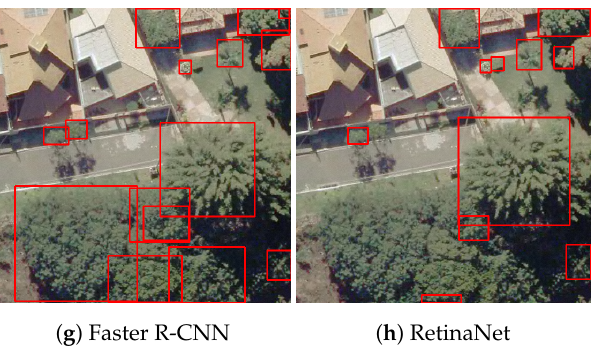
Figure 14. Tree detection with the top five methods, RetinaNet, and Faster R-CNN: performance considering big trees.